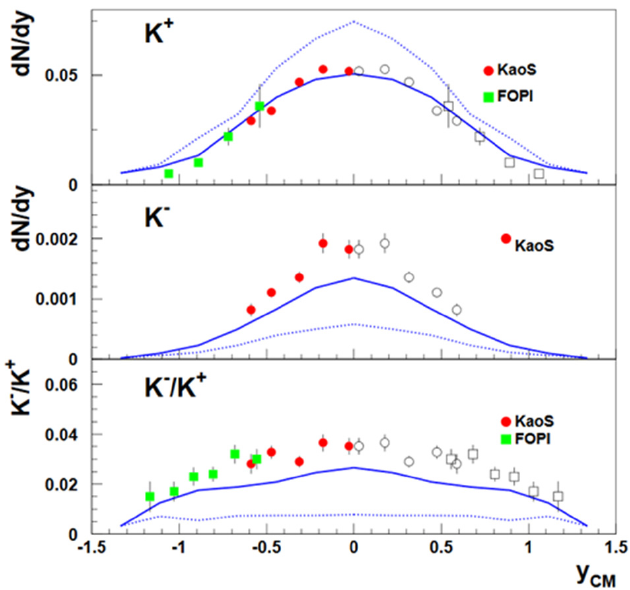
Figure 12. Multiplicity density distributions of K + mesons (upper panel), K − mesons (center panel) and the K + /K − ratio (lower panel) for near-central ( b < 4.4 fm) Ni+Ni collisions at 1.93A GeV, measured by KaoS (red circles) [47] and FOPI (green squares) [48,49]. The measured data (full symbols) are mirrored at y CM = 0 (open symbols). The data are compared to BUU transport calculations [50]. Solid lines: with in-medium effects. Dotted lines: without in-medium effects. Taken from [33].